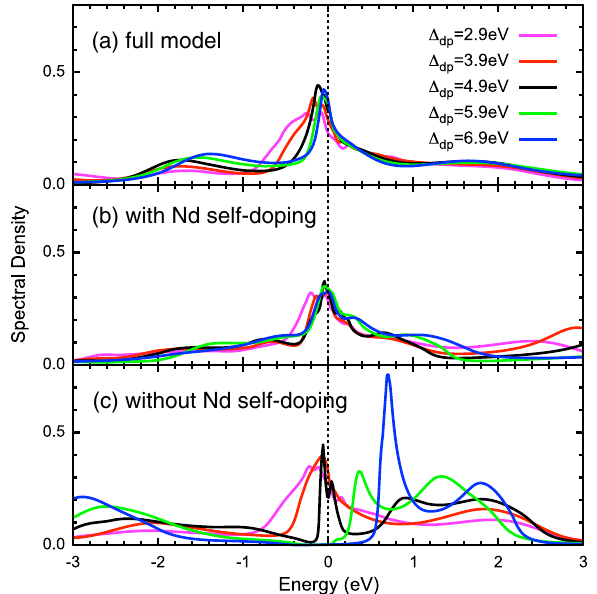
FIG. 3. The x 2 − y 2 spectral densities computed in (a) the full model [the same as in Fig. 2(a)], (b) model (i) with a self-doping from Nd d bands, and (c) model (ii) without a self-doping from Nd d bands.